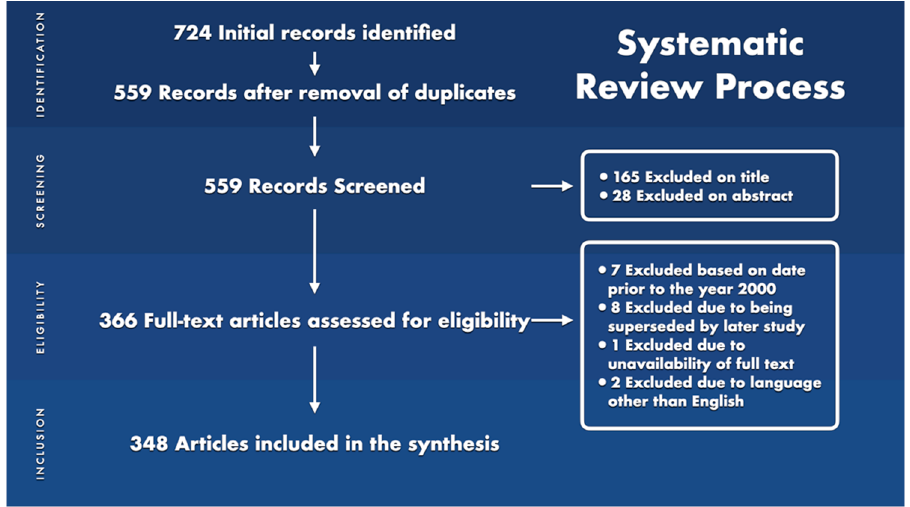
Figure 1. A flowchart describing the PRISMA Systematic Review Process applied in this